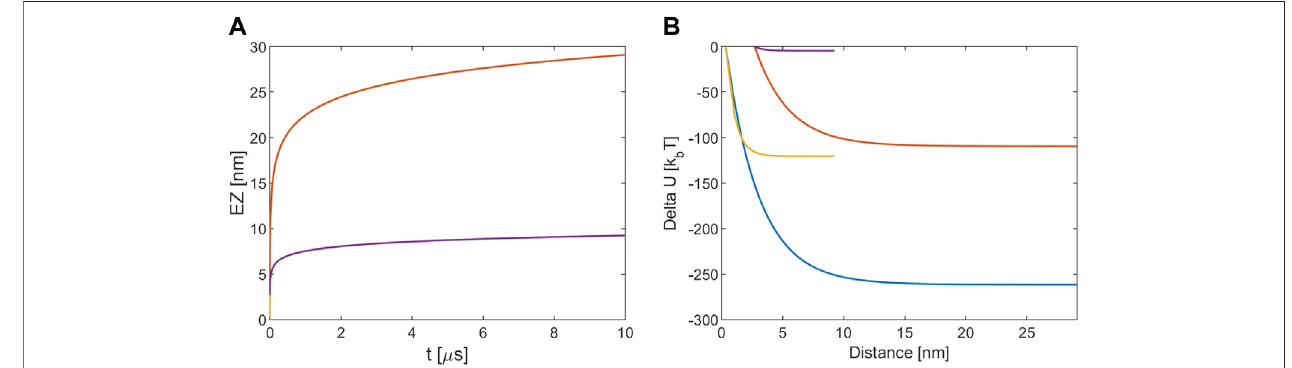
FIGURE1|(A) EZfromMT. (B) Electrostaticpotentialenergy variation.Theblueand redlinesreferto[KCl]=10 mM, r(0)=R+dand r(0)=R+a,respectively. The yellowandvioletlinesreferto[KCl]=160 mM,r(0)=R+dandr(0)=R+a,respectively.NotethatfortheEZtheblueandtheyellowlinesaremaskedbytheredandviolet one because processes times are almost